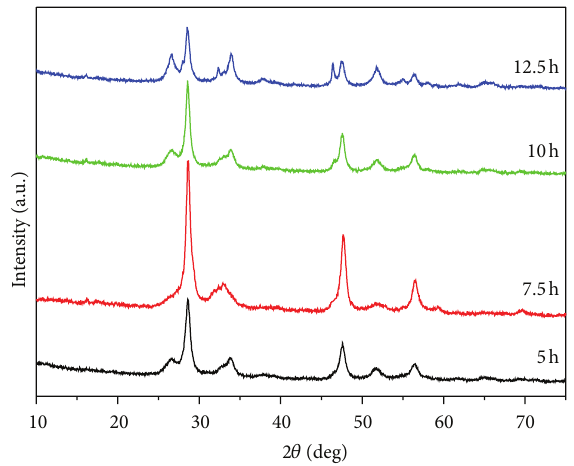
Figure 5: XRD spectra of the obtained samples at 200 ∘ C for the different reaction times.